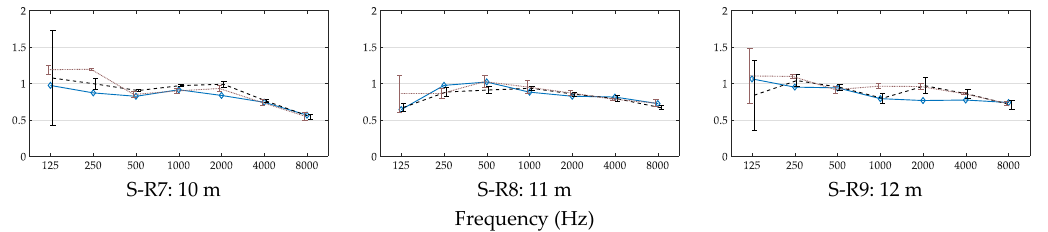
Figure 6. Early decay time measurements at different source – receiver (S-R) distances. Error bars represent measured standard deviation.